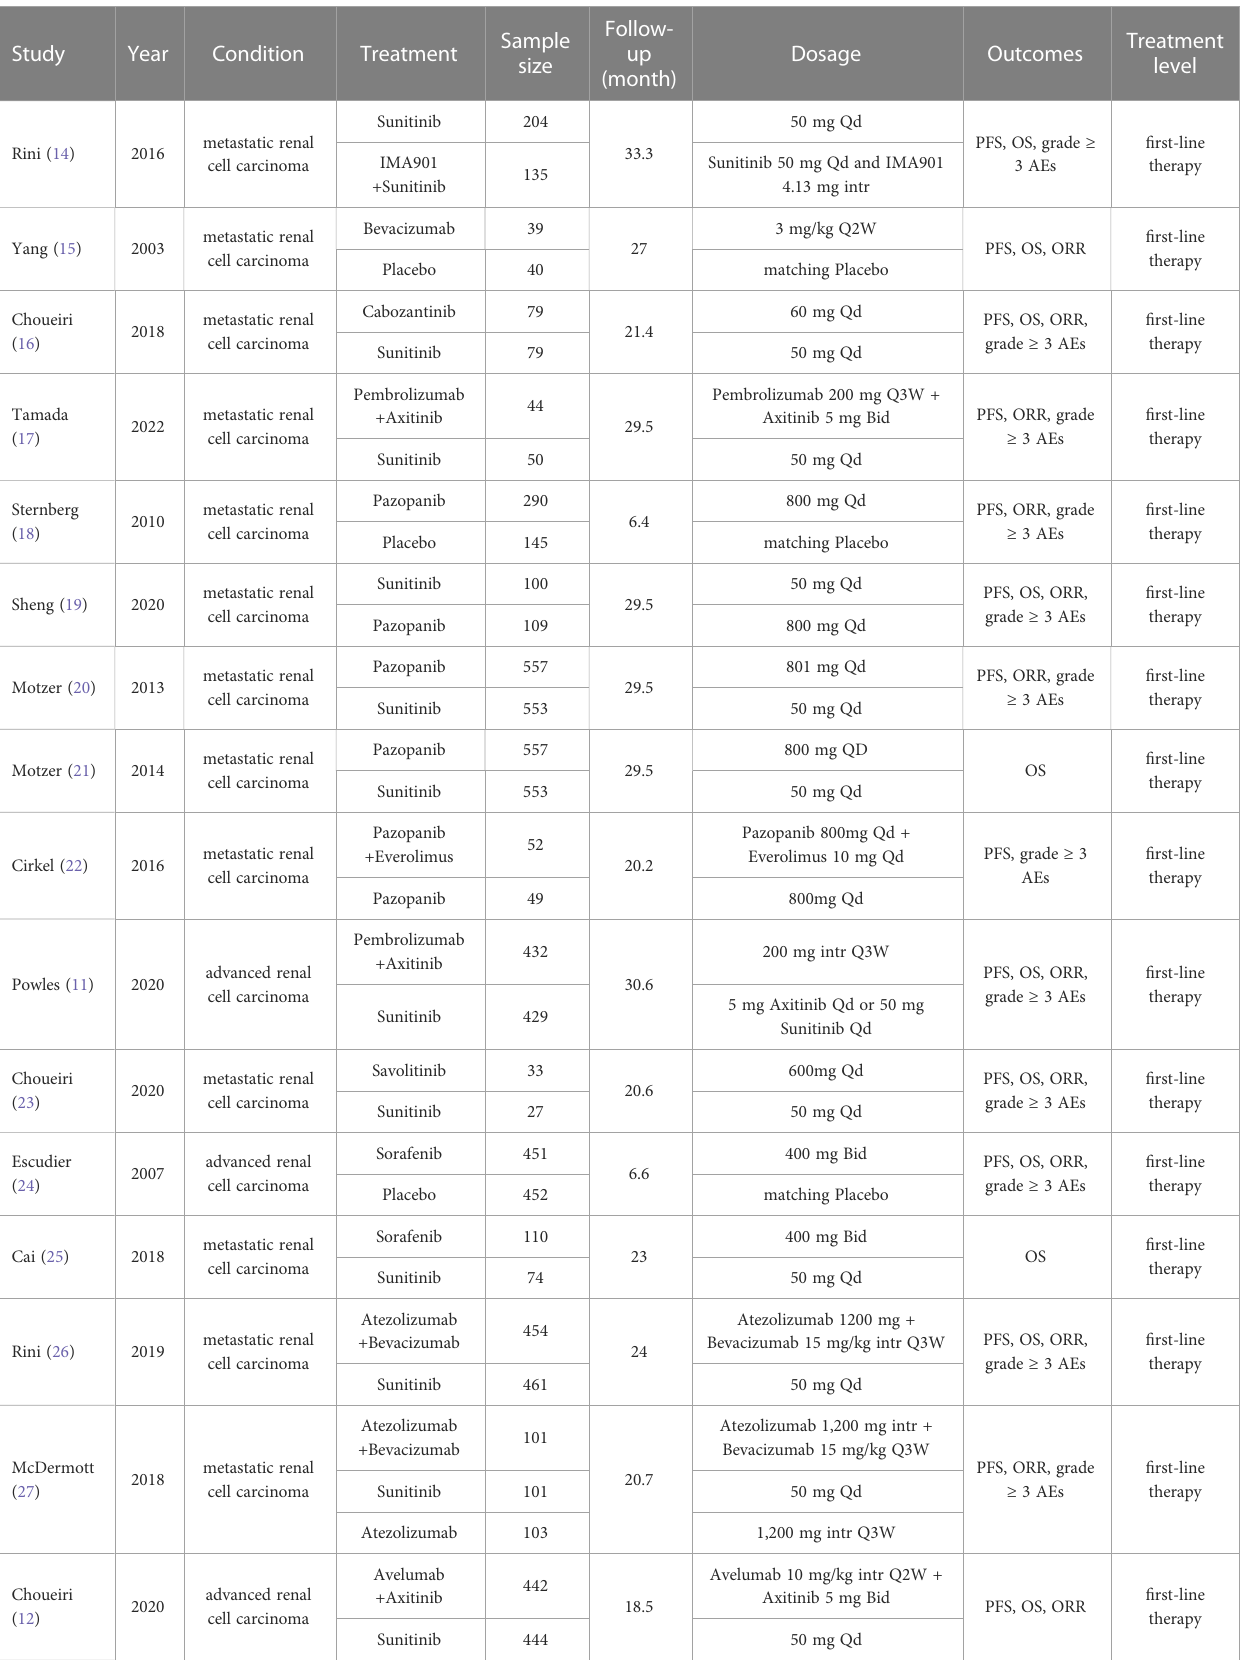
TABLE 1 Characteristics of fi rst-line systemic therapy for metastatic renal cell carcinoma studies included in the network meta-analysis. Study Year Condition Treatment